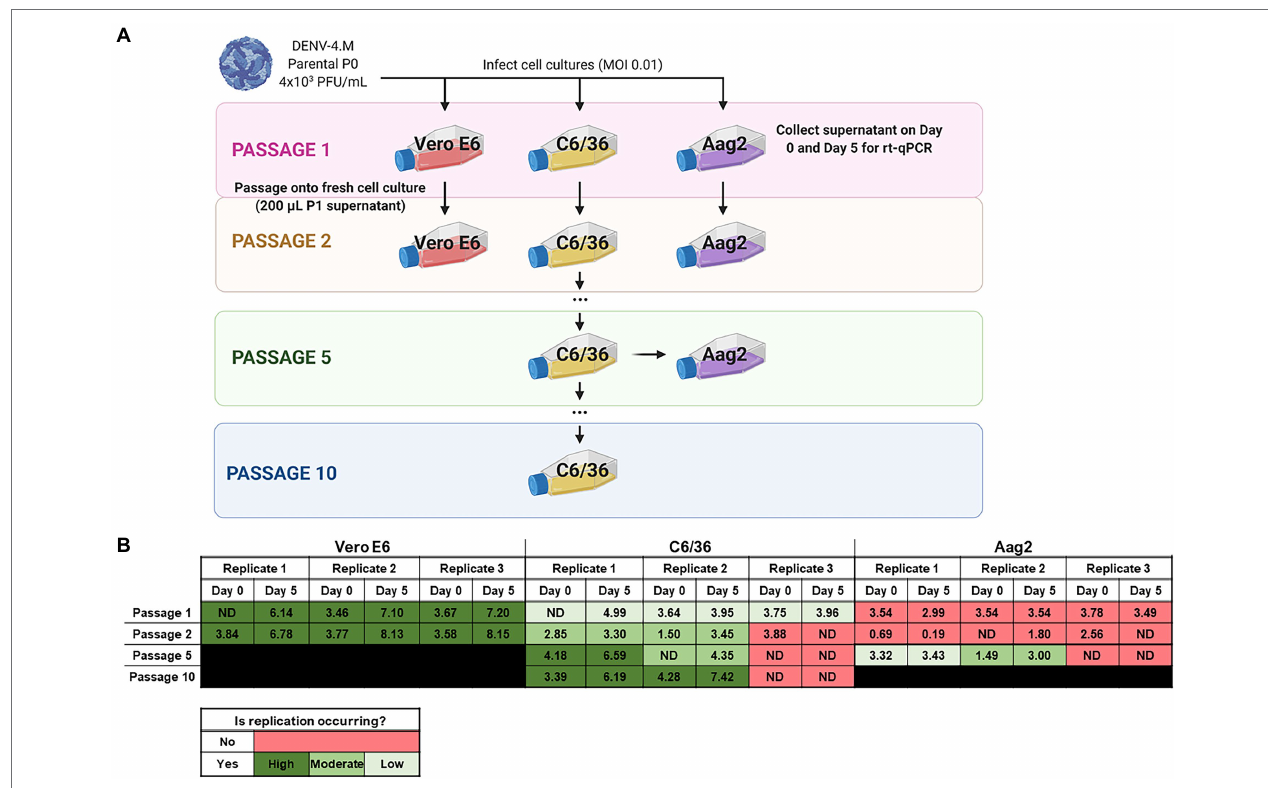
FIGURE 3 | Detection of Manatee IC replication in mammalian and insect cells by reverse transcription quantitative PCR (rt-qPCR) on culture supernatant shows DENV-4M completes replication in insect cell lines and can be adapted to insect cell culture by serial passage. (A) Workflow schematic of serial passage experiment. One mammalian (Vero E6) and two mosquito (C6/36 and Aag2) cell lines were infected with parental (P0) DENV-4M stock virus. Cell culture supernatant was taken at day 0 (immediately following removal of inoculum) and day 5 post infection for rt-qPCR. On 5 dpi, supernatant from the infected culture was serially passaged onto an uninfected culture. Additionally, C6/36 P5 virus was used to infect Aag2 cell culture to test if adaptation to an insect cell line improves the performance of the virus in Aag2 cells. (B) Log 10 DENV-4 PFU equivalents (PFUe)/ml, as determined by converting cycle threshold values with a standard curve made using 10-fold dilutions of RNA extracted from virus stock with a known PFU of 7 × 10 6 are reported for the indicated conditions. The values reported represent the mean of two technical rt-qPCR replicates. ND indicates that no viral genome was detected in the indicated condition. The limit of detection (LOD) of the assay was a cycle threshold value of 40 or 0.65 PFUe/ml The three biological replicates reported were performed in separate tissue culture flasks processed in